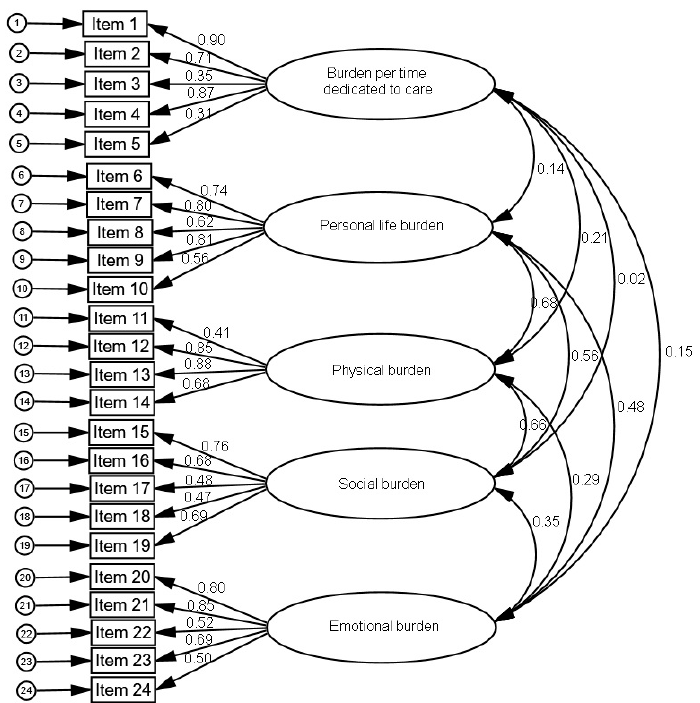
Figure 1. Results of the confirmatory factorial analysis for the original caregiver burden inventory (CBI). (2) Relationship between the original CBI and GHQ-12